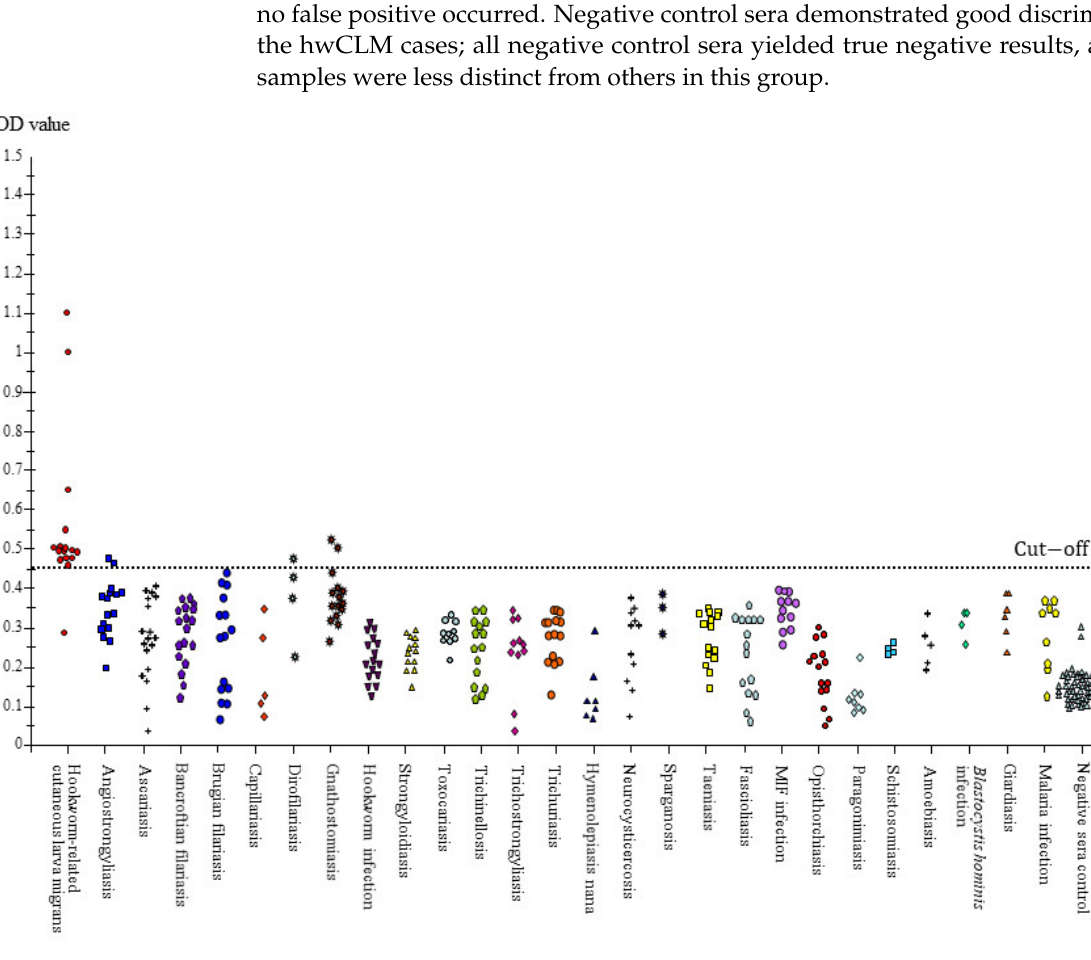
Figure 6. Scatter patterns of IgG-ELISA absorbance values of serum samples from hookworm-related CLM, 27 different diseases, and negative control against A. caninum crude antigen. Ag–Ab reactions were accomplished under ELISA conditions, 0.25 µg/mL of Ag concentration, 1:1600 diluted serum samples, and an anti-human IgG dilution of 1:2000 at a cut-off value of 0.451.